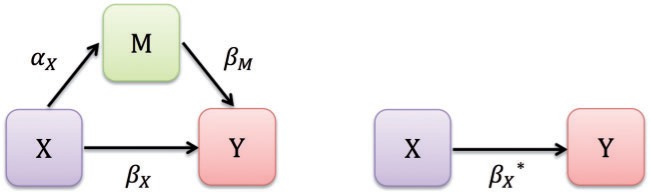
Simple mediation model for exposure \documentclass[12pt]{minimal}
\usepackage{amsmath}
\usepackage{wasysym}
\usepackage{amsfonts}
\usepackage{amssymb}
\usepackage{amsbsy}
\usepackage{upgreek}
\usepackage{mathrsfs}
\setlength{\oddsidemargin}{-69pt}
\begin{document}
}{}$X$\end{document}, continuous mediator \documentclass[12pt]{minimal}
\usepackage{amsmath}
\usepackage{wasysym}
\usepackage{amsfonts}
\usepackage{amssymb}
\usepackage{amsbsy}
\usepackage{upgreek}
\usepackage{mathrsfs}
\setlength{\oddsidemargin}{-69pt}
\begin{document}
}{}$M$\end{document}, and continuous outcome \documentclass[12pt]{minimal}
\usepackage{amsmath}
\usepackage{wasysym}
\usepackage{amsfonts}
\usepackage{amssymb}
\usepackage{amsbsy}
\usepackage{upgreek}
\usepackage{mathrsfs}
\setlength{\oddsidemargin}{-69pt}
\begin{document}
}{}$Y$\end{document}. The coefficients \documentclass[12pt]{minimal}
\usepackage{amsmath}
\usepackage{wasysym}
\usepackage{amsfonts}
\usepackage{amssymb}
\usepackage{amsbsy}
\usepackage{upgreek}
\usepackage{mathrsfs}
\setlength{\oddsidemargin}{-69pt}
\begin{document}
}{}$\alpha_X,\beta_X,\beta_M,$\end{document} and \documentclass[12pt]{minimal}
\usepackage{amsmath}
\usepackage{wasysym}
\usepackage{amsfonts}
\usepackage{amssymb}
\usepackage{amsbsy}
\usepackage{upgreek}
\usepackage{mathrsfs}
\setlength{\oddsidemargin}{-69pt}
\begin{document}
}{}$\beta_X^*$\end{document} are estimated from the system of three regression equations.